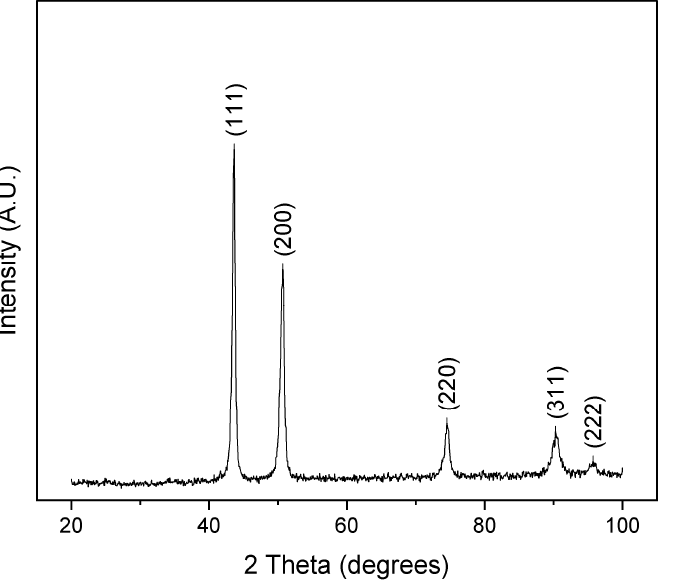
Figure 11. XRD diffractogram of as-cast Mn 17 Fe 21 Co 24 Ni 24 Cu 14 alloy showing single phase FCC diffraction peaks.